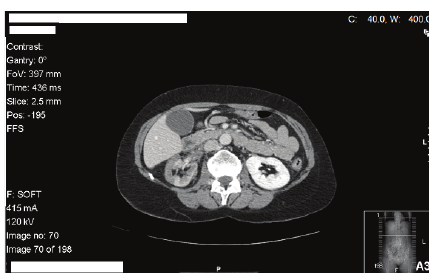
Figure 1: Abdominal Computer Tomography (CT) scan showing diffuse reduction in the parenchymal thickness of the right kidney and multiloculated fluid collection of about 10 centimetres (cm), involving the anterior part and the upper pole of the right kidney and the ipsilateral renal